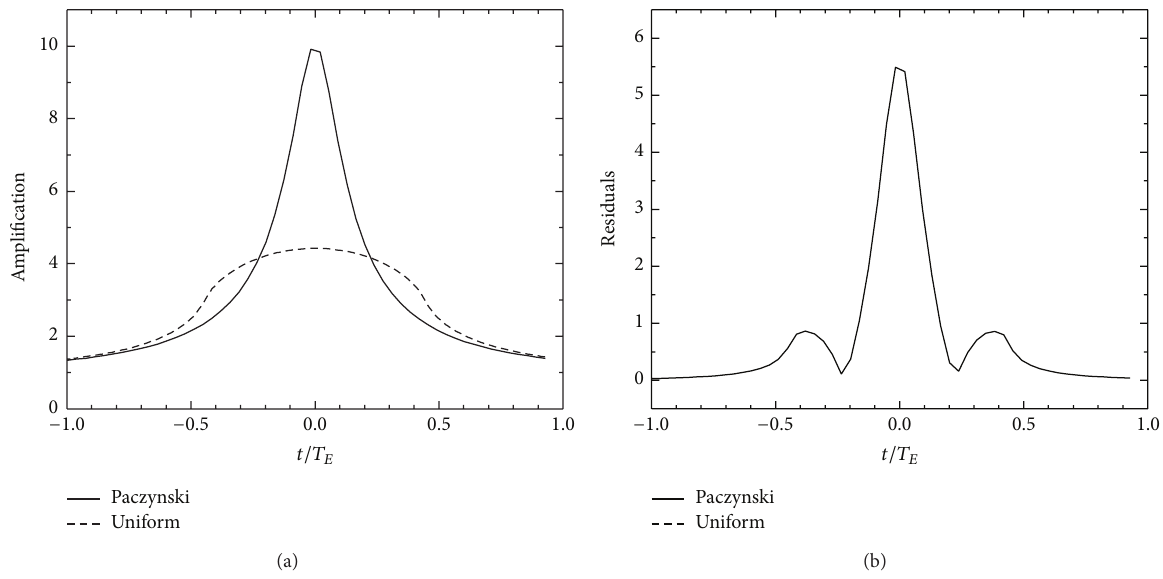
Figure 1: (a) Time variation of the amplification for a microlensing event when the source is assumed to be point-like (continuous line) and extended with a uniform brightness profile (dashed line). The event parameters are 𝑢 0 = 0.1 , 𝜌 ∗ = 0.46 , and 𝑇 𝐸 = 9.2 hours. The duration of the lens transit over the source disk turns out to be 𝑇 ≃ 0.9𝑇 𝐸 = 8.2 hours, consistent with (1). (b) The residuals between the two curves as a function of time (in units of the Einstein time of the